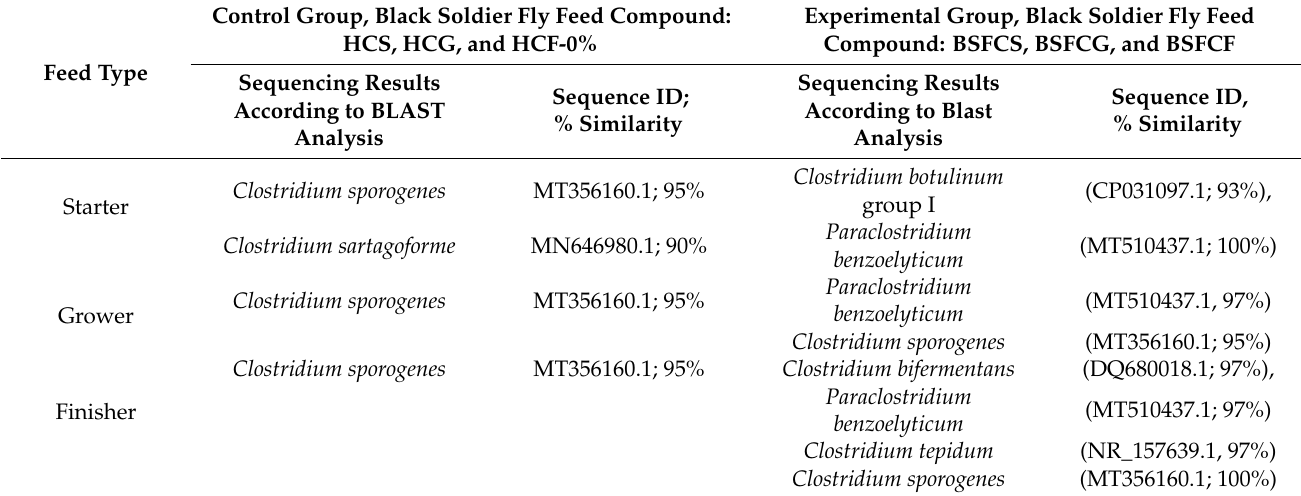
Table 10. Sequencing results for the black soldier fly feed compound